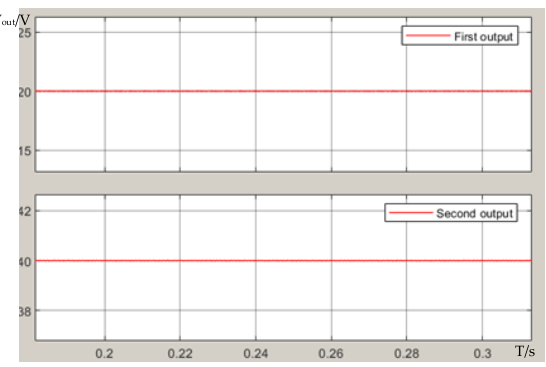
Figure 10. Output voltage across high gain converter.